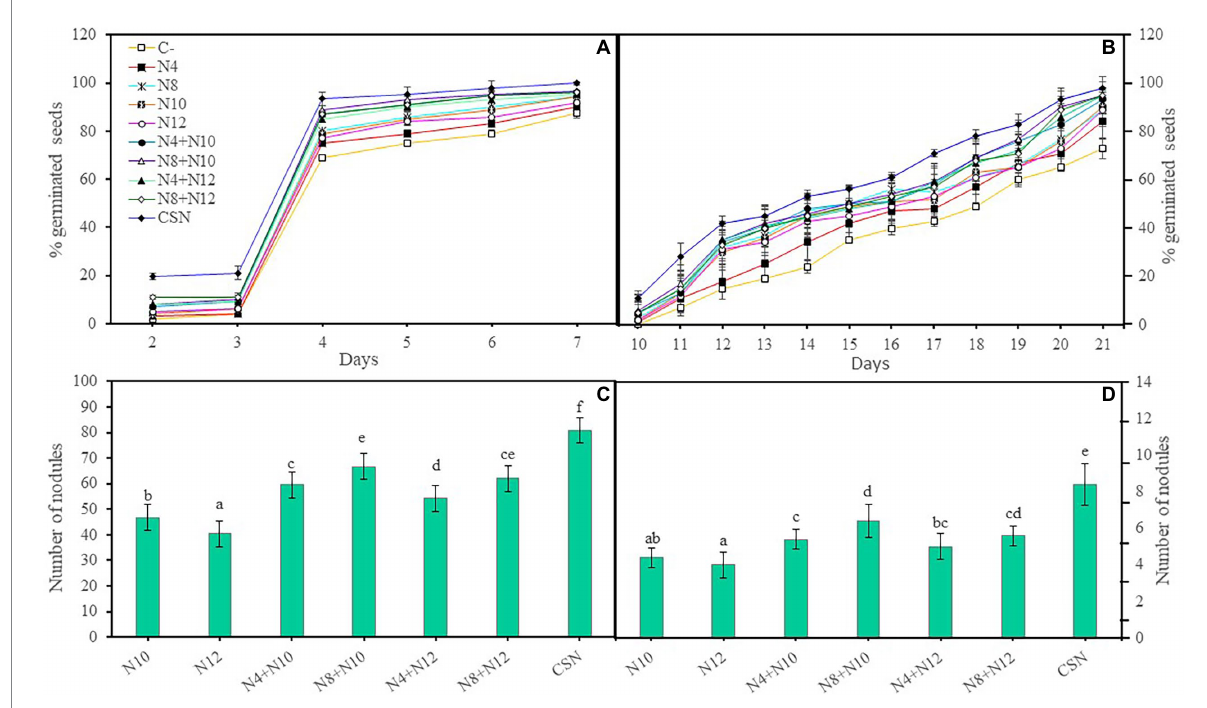
FIGURE 1 In vitro effects of inoculation of M. sativa with selected PGPNE. (A) Percentage of germinated seeds without metals and (B) with metals. Values are means ± S.D. ( n = 50). (C) Number of nodules in plants without As and (D) with As. Values are means ± S.D. ( n = 5). Different letters indicate statistical differences between means (One-way ANOVA, LSD test, p < 0.0001). C-: non inoculation; N4: inoculation with Pseudomonas sp. N4; N8: inoculation with Pseudomonas sp. N8; N10: inoculation with Ensifer sp. N10; N12: inoculation with Ensifer sp. N12; N4 + N10: co-inoculation with Pseudomonas sp. N4 and Ensifer sp. N10; N8 + N10: co-inoculation with Pseudomonas sp. N8 and Ensifer sp. N10; N4 + N12: co-inoculation with Pseudomonas sp. N4 and Ensifer sp. N12; N8 + N12: co-inoculation with Pseudomonas sp. N8 and Ensifer sp. N12; CSN: inoculation with Pseudomonas sp. N4, Pseudomonas sp. N8, Ensifer sp. N10 and Ensifer sp.